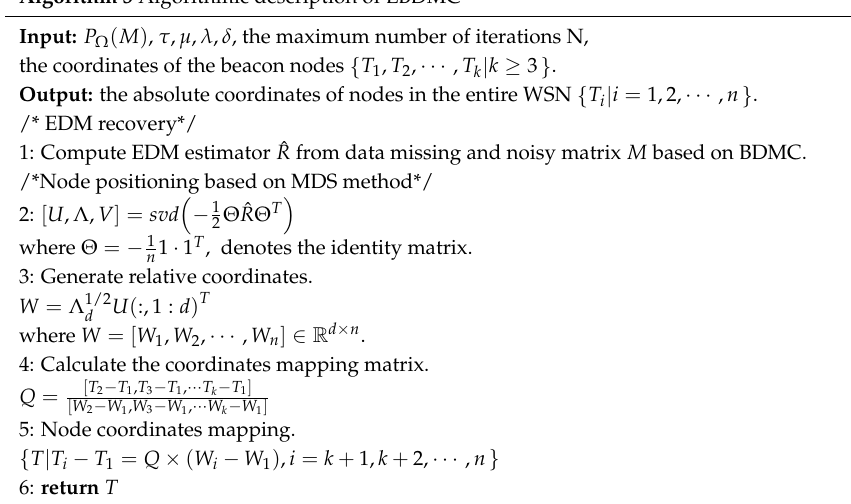
Algorithm 3 Algorithmic description of